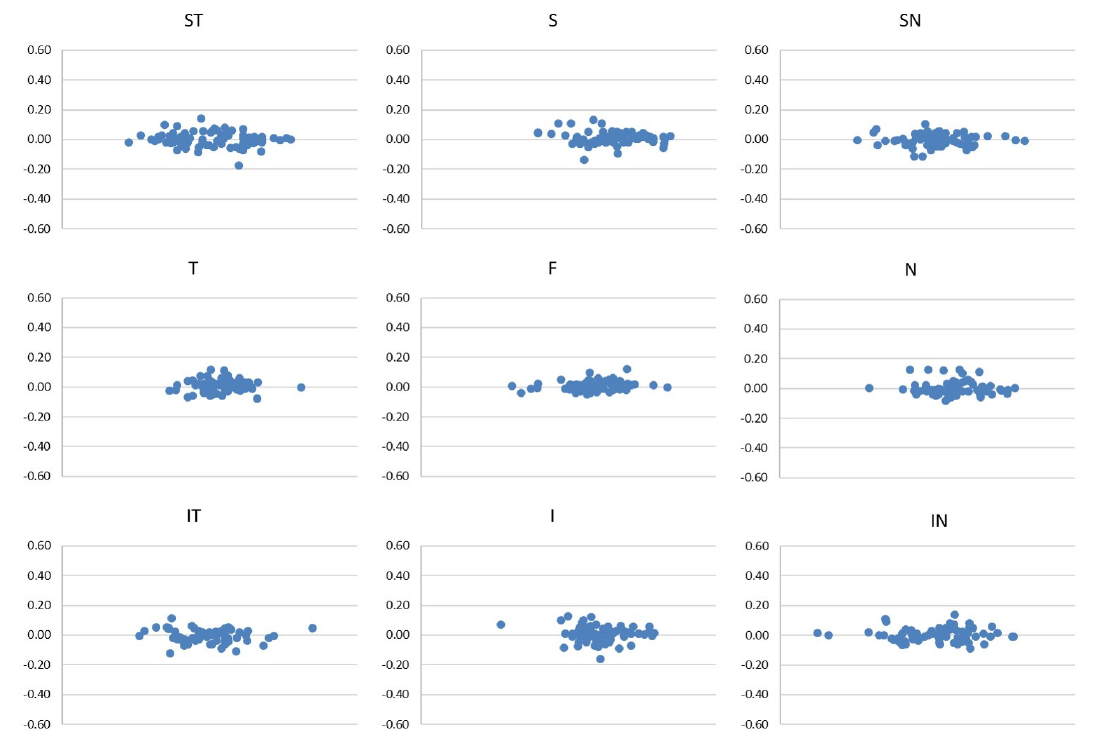
Figure 5. Bland–Altman plots of the first and the second scan of each sector of DCP.